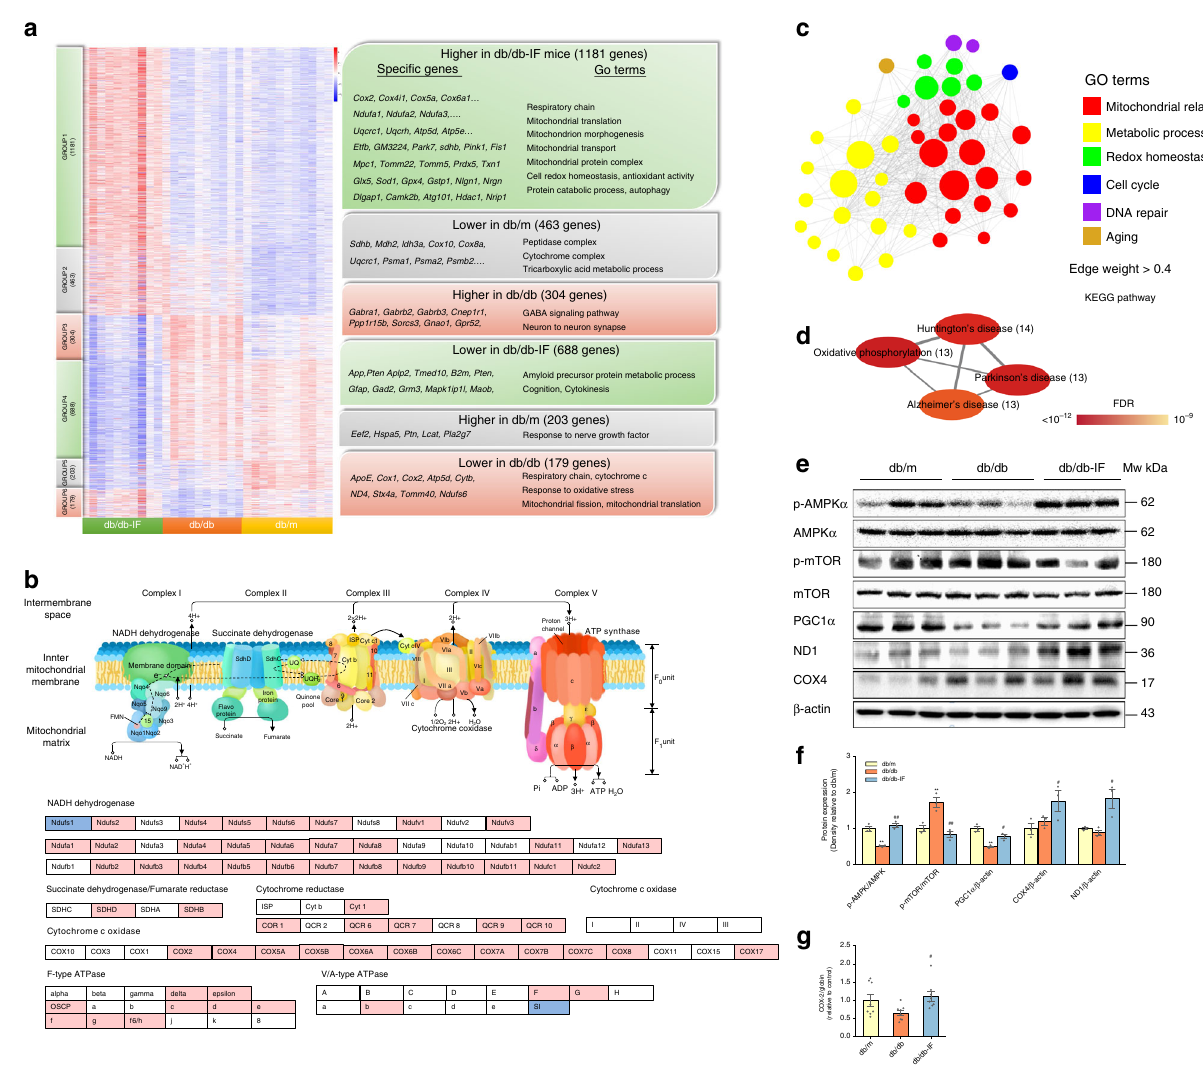
Fig. 3 Intermittent fasting improved energy metabolism and mitochondrial biogenesis in the hippocampus. a Heatmap displaying 2503 differentially expressed genes in the hippocampus among db/m, db/db, and db/db-IF groups ( n = 11, 9, 11 mice in each group, respectively) that were clustered into six distinct gene groups through DEG analysis using Ballgown software (FDR- p < 0.05). Enriched GO terms (FDR- p < 0.05) and representative genes are shown on the right for each cluster. The p -values of GO terms were determined on the WebGestalt website; b KEGG of oxidative phosphorylation (FDR- p < 0.05) of group 1 (1181) and group 4 (688) genes based on DEG analysis. Pink represents upregulation during Intermittent fasting. Blue represents downregulation during Intermittent fasting. c Network and GO annotation of 49 brown-module hub genes (upregulated when intermittent fasting, r[ME and gene] > 0.8, r[trait and gene] > 0.85, FDR- p < 0.01) in WGCNA analysis (edge weights > 0.4). The p -values of GO terms were determined on the WebGestalt website; d KEGG analysis (FDR- p < 0.05) of the brown-module hub genes in the WGCNA analysis. The p -values of KEGG analysis were determined on the WebGestalt website; e , f Western blots of mTOR/AMPK/PGC1 α signaling ( n = 3 mice per group); g mitochondrial DNA levels in brain tissue ( n = 8 mice per group). Data of f , g presented as mean ± SEM. * p < 0.05, ** p < 0.01, compared with the db/m group, # p < 0.05, ## p < 0.01 compared with the db/db group. Signi fi cant differences in d , g between mean values were determined by one-way ANOVA with Tukey ’ s multiple comparisons test. The boxplot elements are de fi ned as following: center line, median; box limits, upper and lower quartiles; whiskers, 1.5 × interquartile range. See also Supplementary Fig. 3 and Supplementary Data 1 – 5. Source data are provided as a Source Data fi